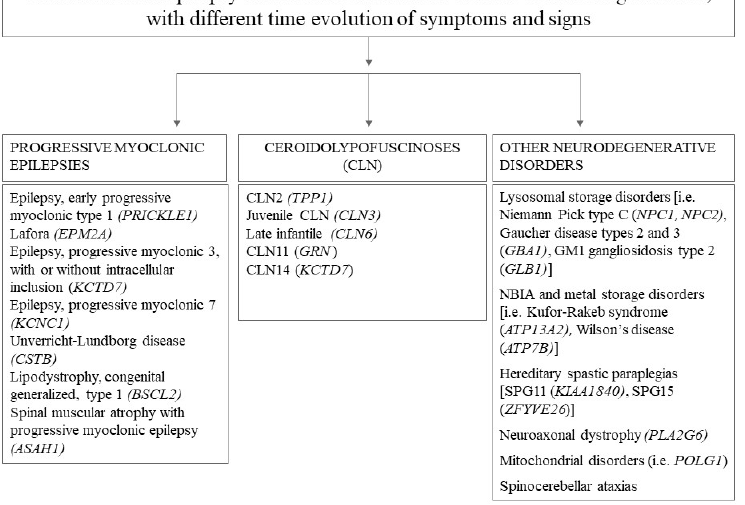
Figure 1. Excluded neurogenic conditions featuring epilepsy and Parkinsonism in the context of neurodegeneration.